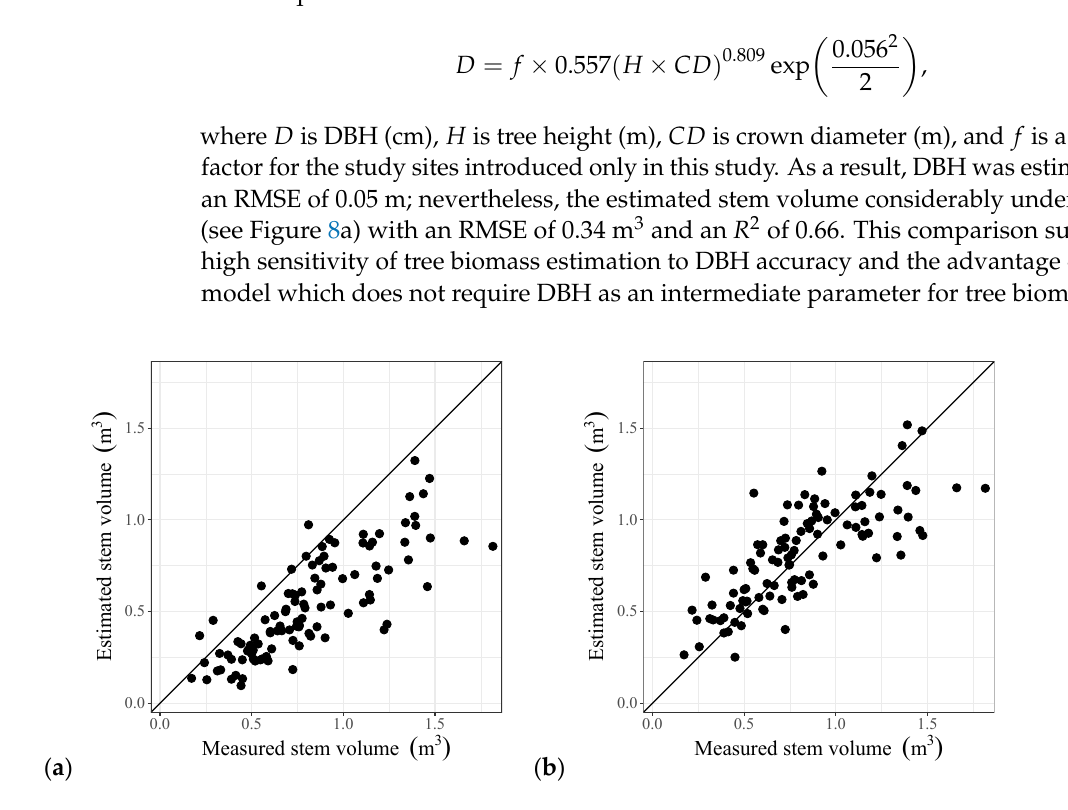
Figure 8. Comparison between the reference tree volume and those estimated using the two comparative models: ( a ) the DBH estimation model [19] and ( b ) the non-linear multiple regression model [21].